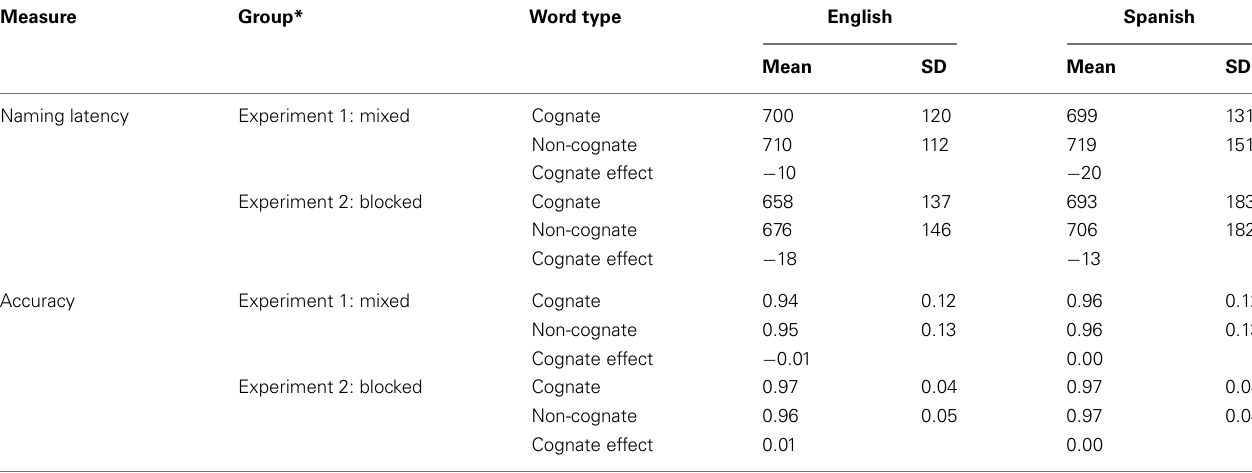
Table 6 | Mixed and blocked group